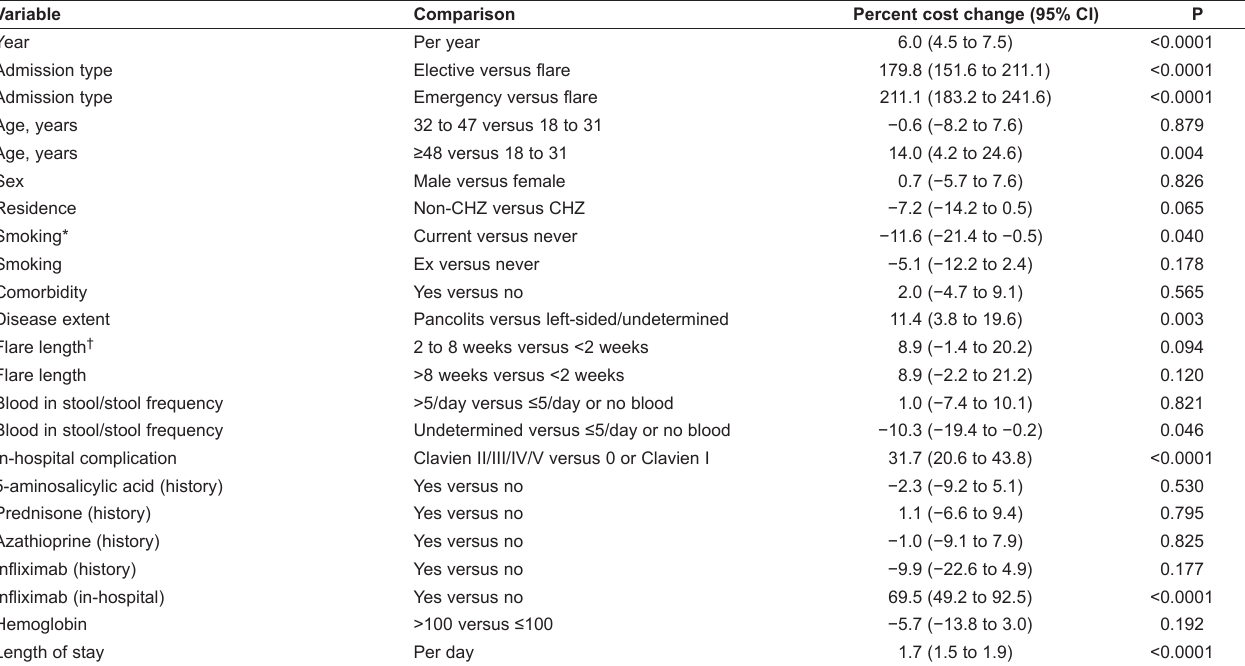
TAble 2 linear regression analysis of